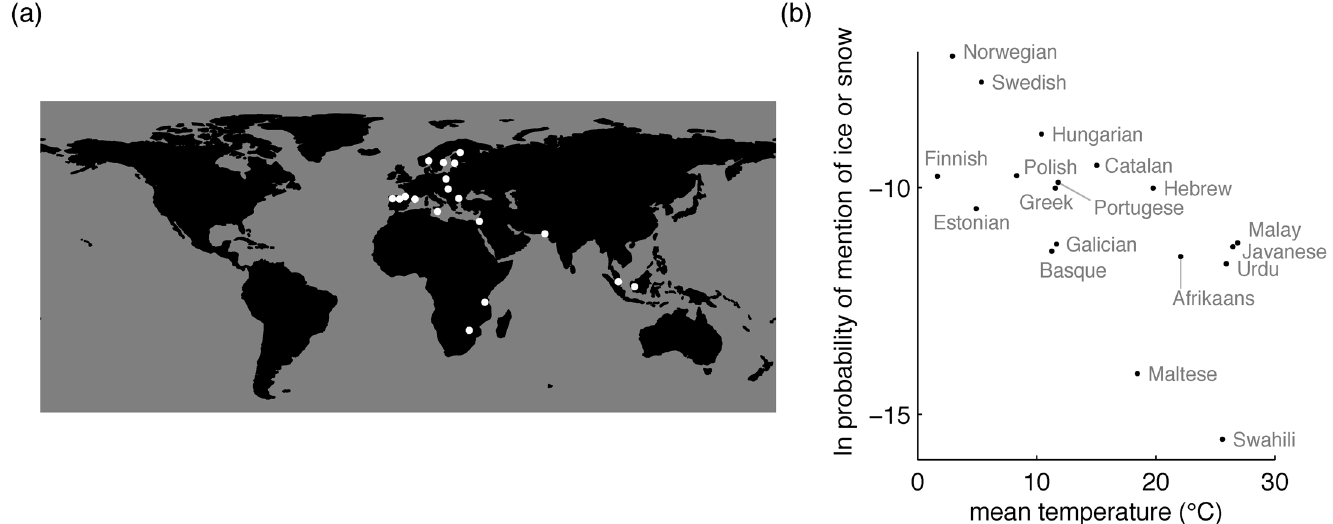
Fig 3. Results of cross-language Twitter analysis. (a) Locations associated with the 18 languages represented in the Twitter dataset we consider. (b) The natural log probability of mention of ice or snow in a given language as a function of the mean temperature where that language is spoken. Mixed effects logistic regression revealed that temperature is negatively associated with probability of mention of ice or snow, as a fixed effect ( β = − 0.29, χ 2 (1) = 21696, p < 10 − 15 ), when including random intercepts for each language family.